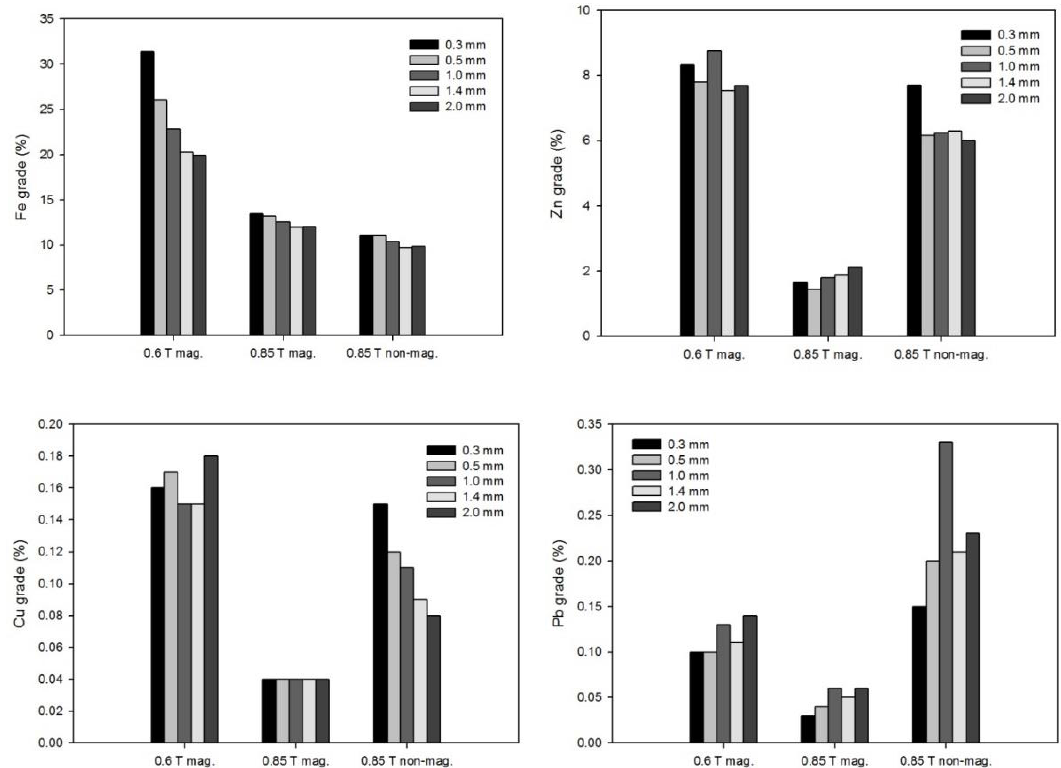
Figure 6. Grade of elements as a function of the magnetic intensity during the separation process. (Abbreviations: mag., magnetic; non-mag., non-magnetic).